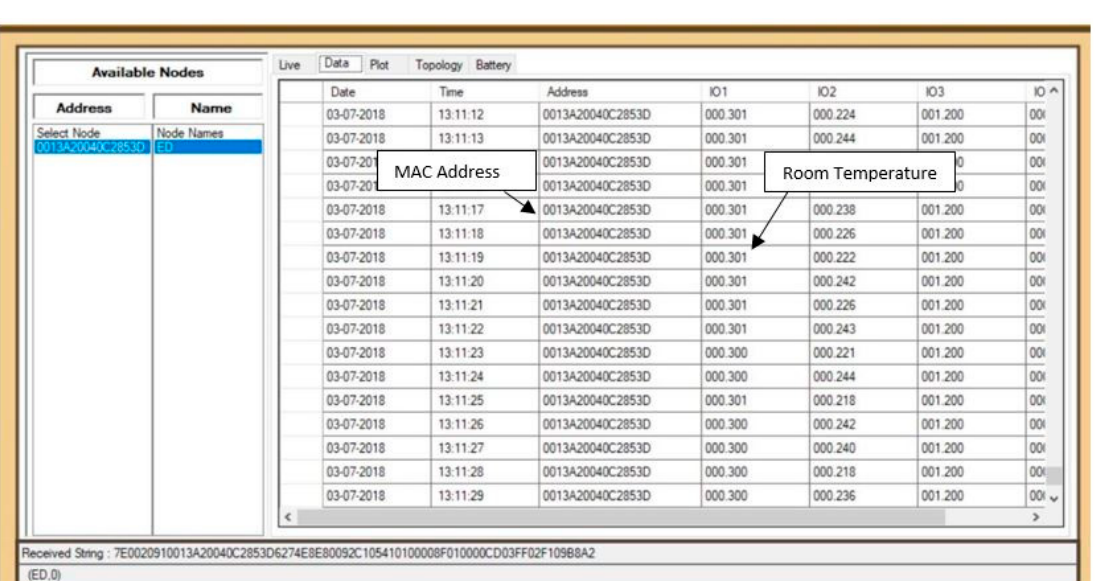
Figure 14. Hardware Experiment setup of SEH-WSN system.